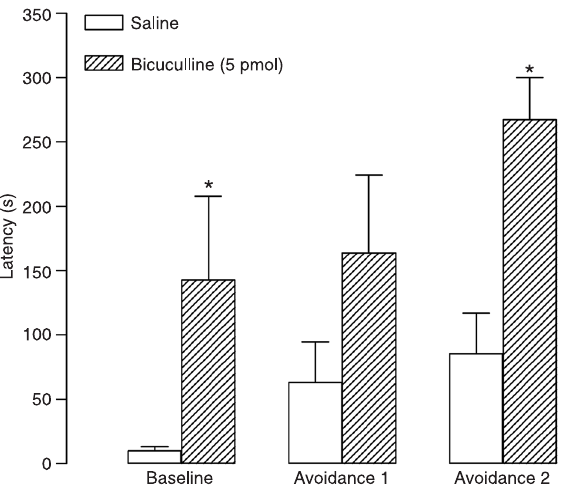
Figure 1 . Effect (means ± SEM) of electrical stimulation of the dorsal periaqueductal gray matter (DPAG) at the escape thresh- old on avoidance latencies measured in the elevated T-maze. Animals were tested in the elevated T-maze 30 min after DPAG electrical stimulation (N = 9). *P < 0.05 compared to the control group in the same trial (repeated measures ANOVA, followed by the Duncan test).